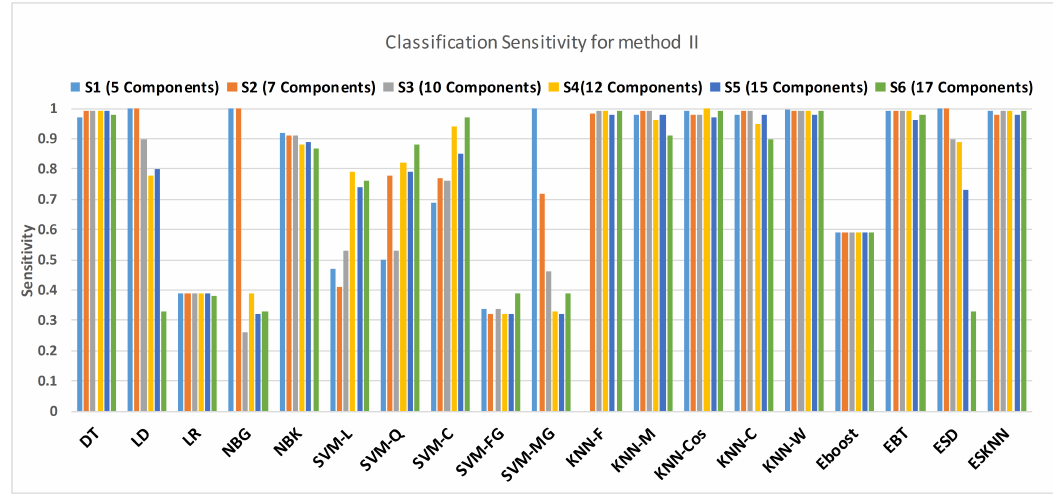
Figure 16. Performance of sensitivity for different feature sets in various classifiers for PuPG signal through method